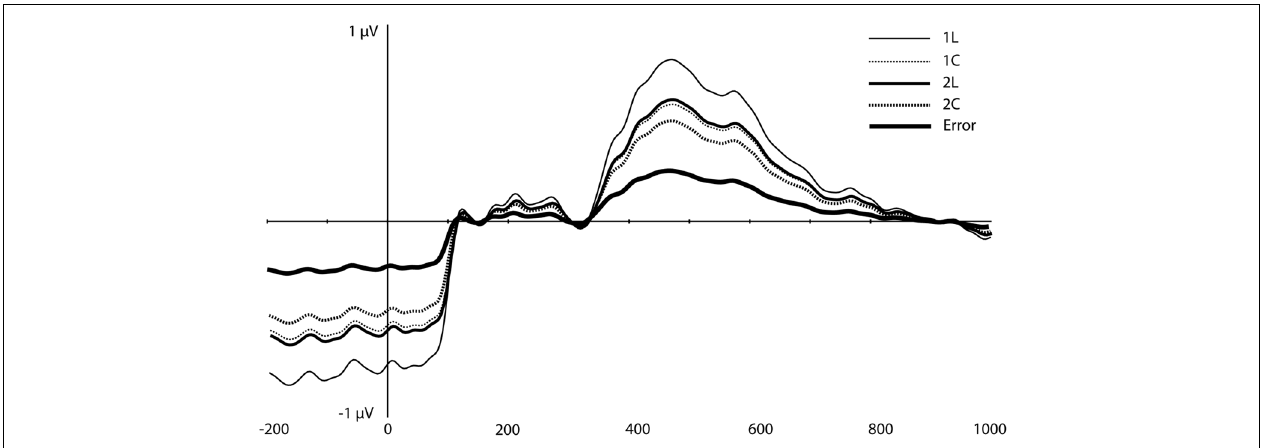
FIGURE 5 | Component 1 (C1) waveforms with error